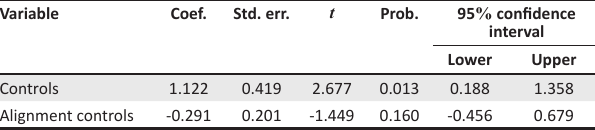
TABLE 4b: Organisational performance.